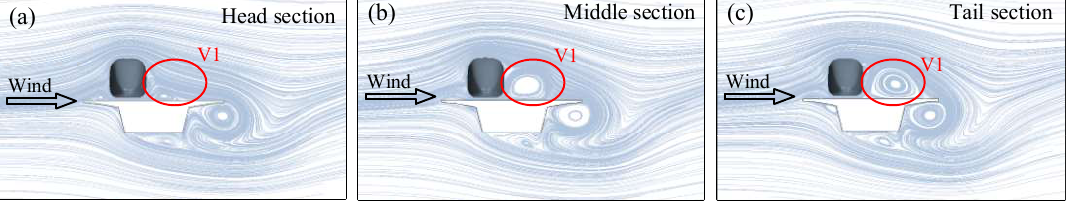
Figure 9. Streamline of the train at different sections in the x -axis ( U = 20 m/s, α = 90°, V = 300 km/h, V R = 85.7 m/s, β = 13.5°): ( a ) head section; ( b ) middle section; ( c ) tail section.